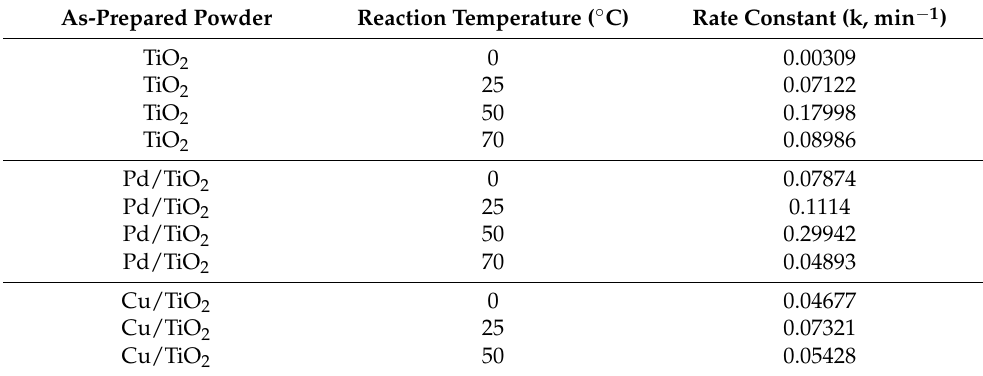
Table 2. Rate constants of reactions of the samples at different reaction